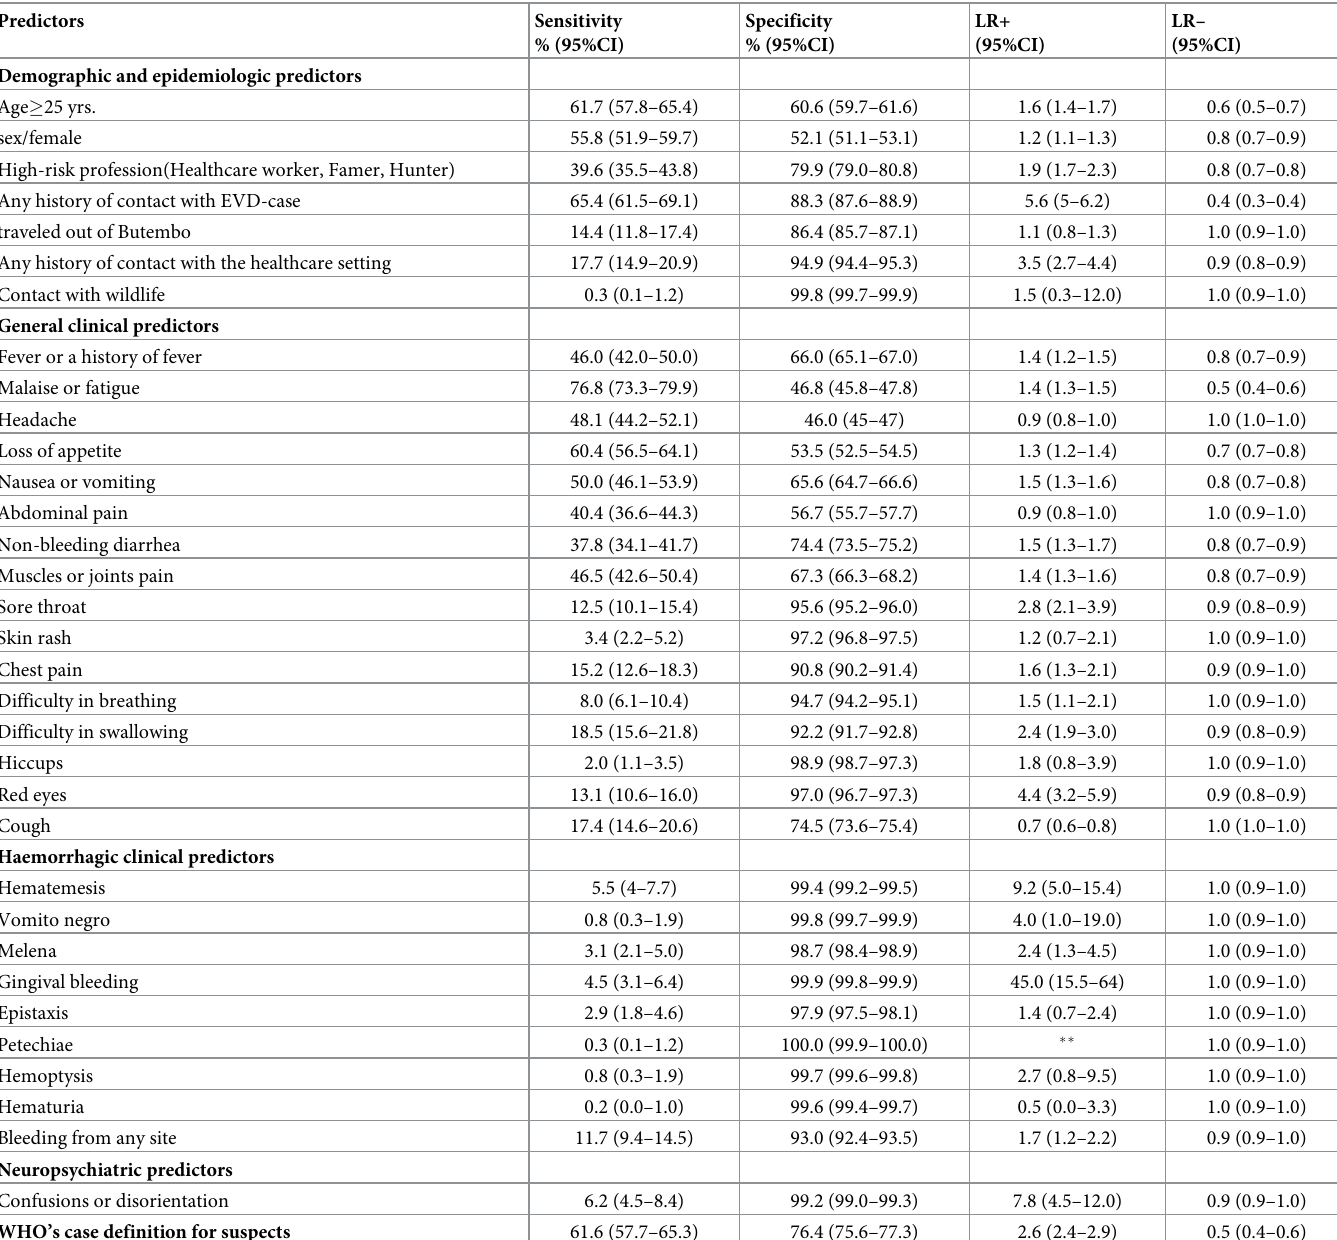
Table 2. Accuracy of demographic, epidemiologic and clinical predictors for the diagnosis of EVD (compared to the reference standard laboratory confirmation).